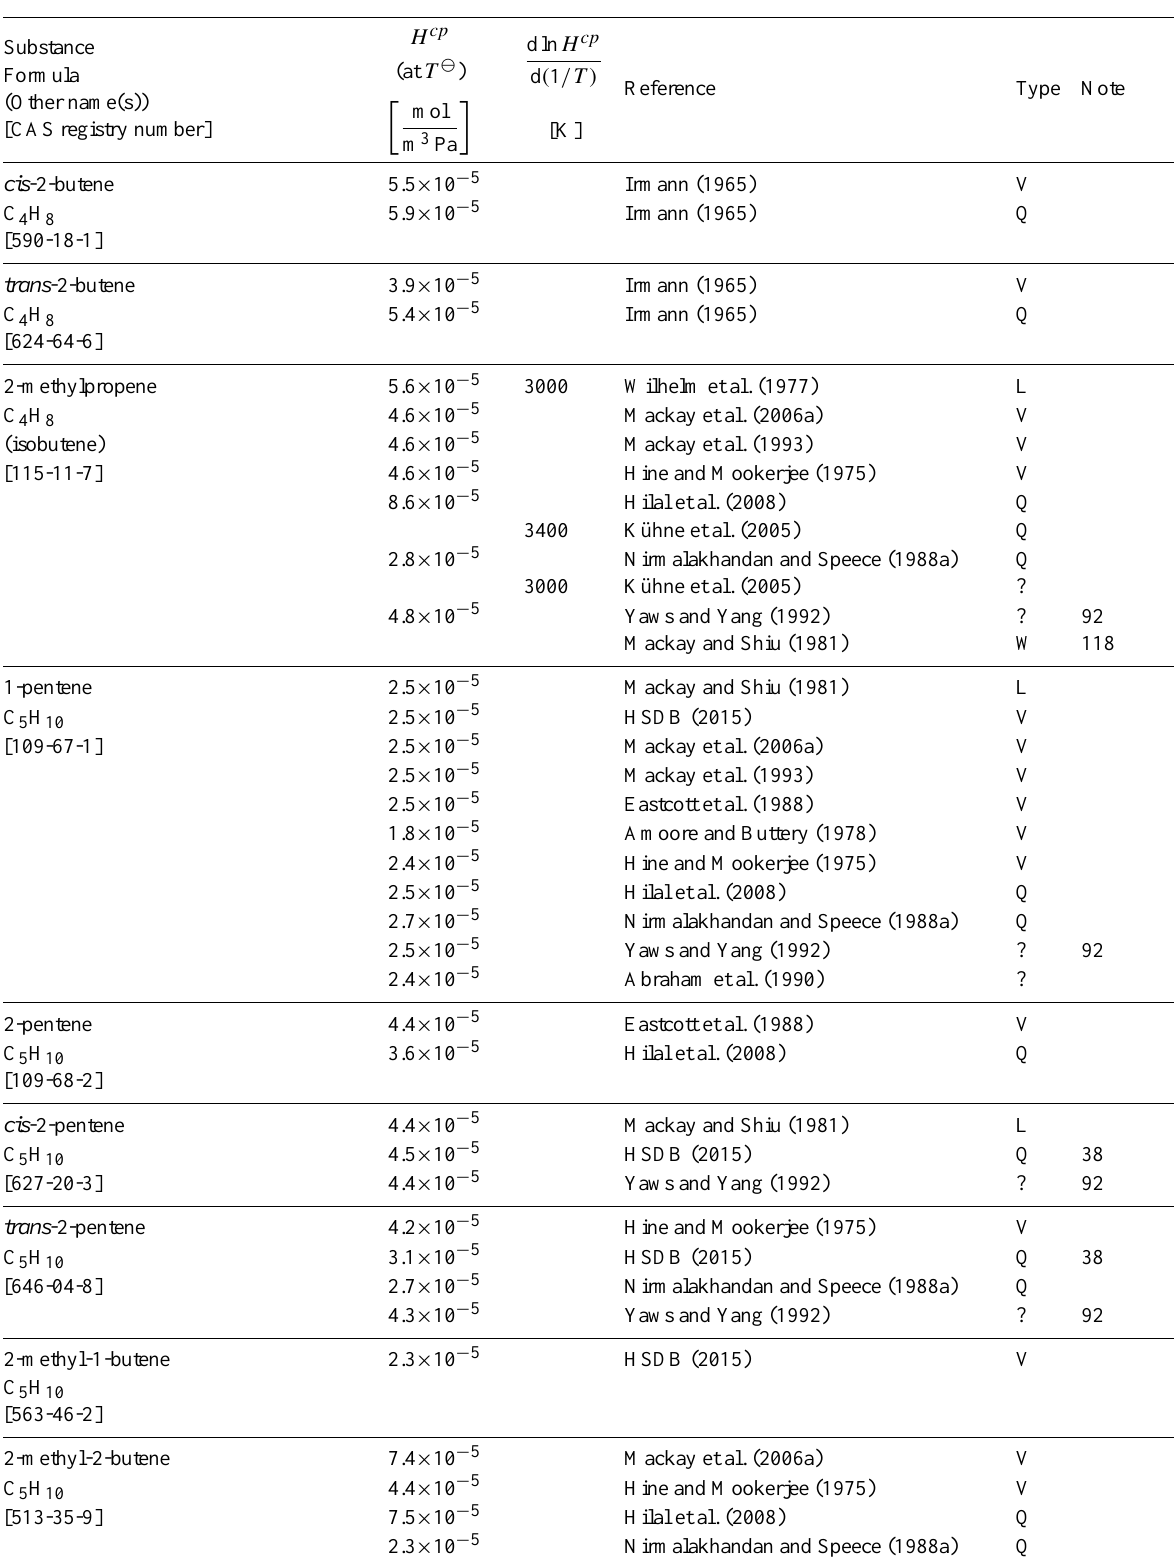
Table 6: Henry’s law constants for water as solvent